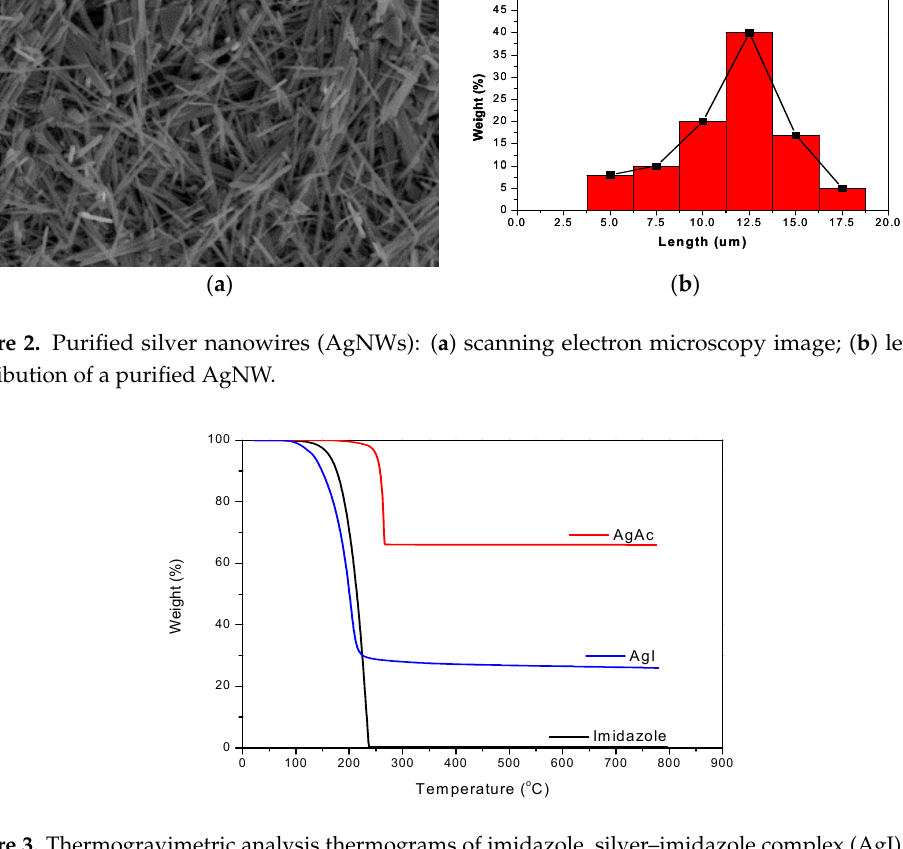
Figure 2. Purified silver nanowires (AgNWs): ( a ) scanning electron microscopy image; ( b ) length distribution of a purified AgNW.